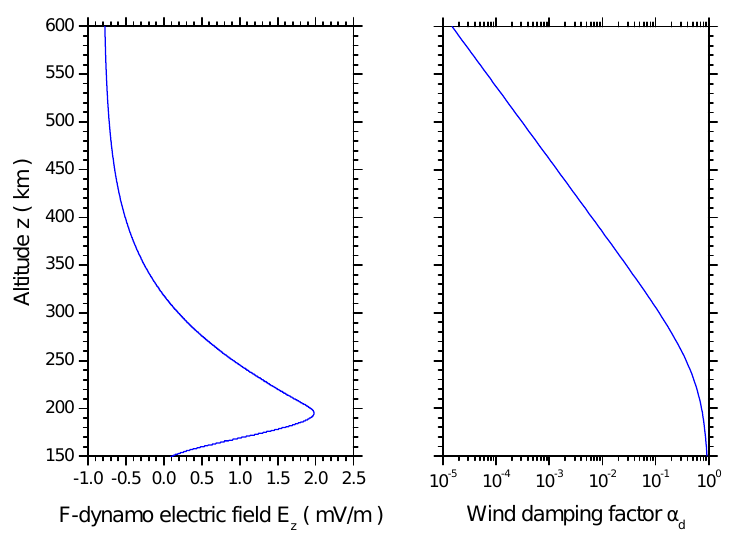
= 140 km at which with z z 0